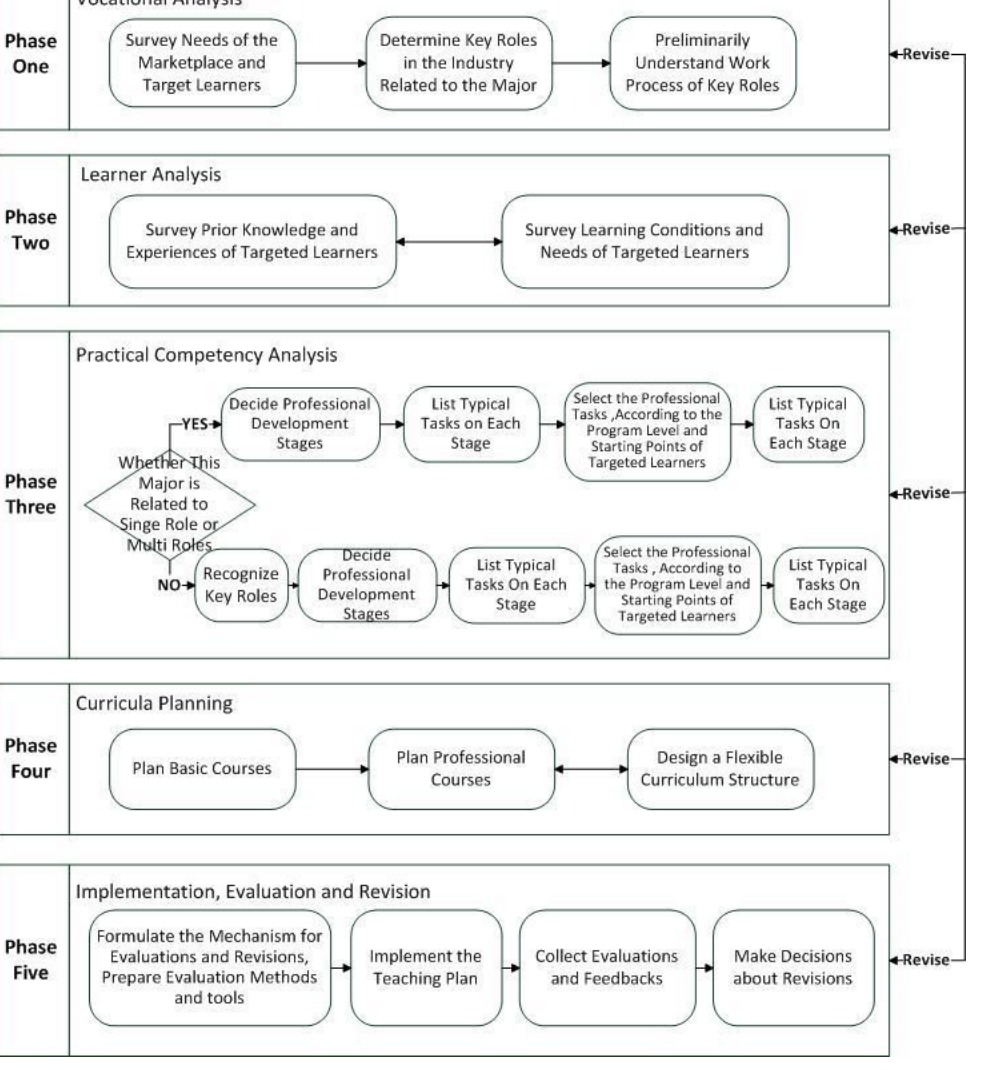
Figure 2. Revised version of the DECDA